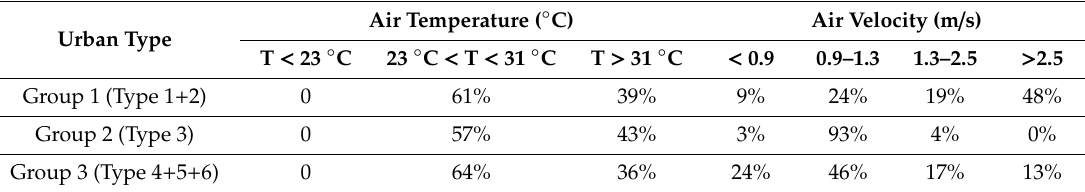
Table 4. The mean outdoor environment found by urban